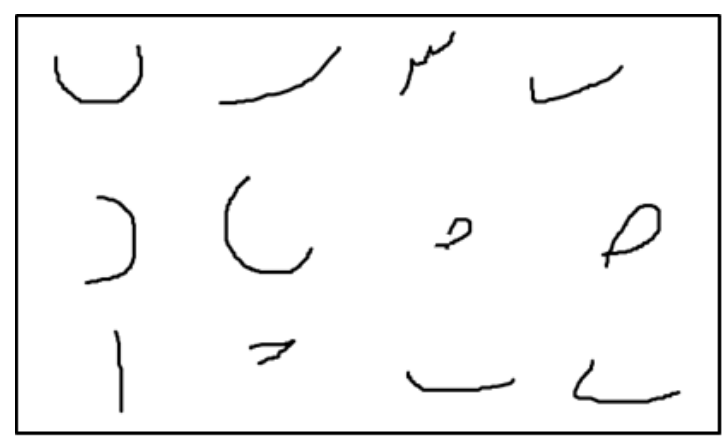
Figure 2. Basic geometrical strokes of Urdu script [33].